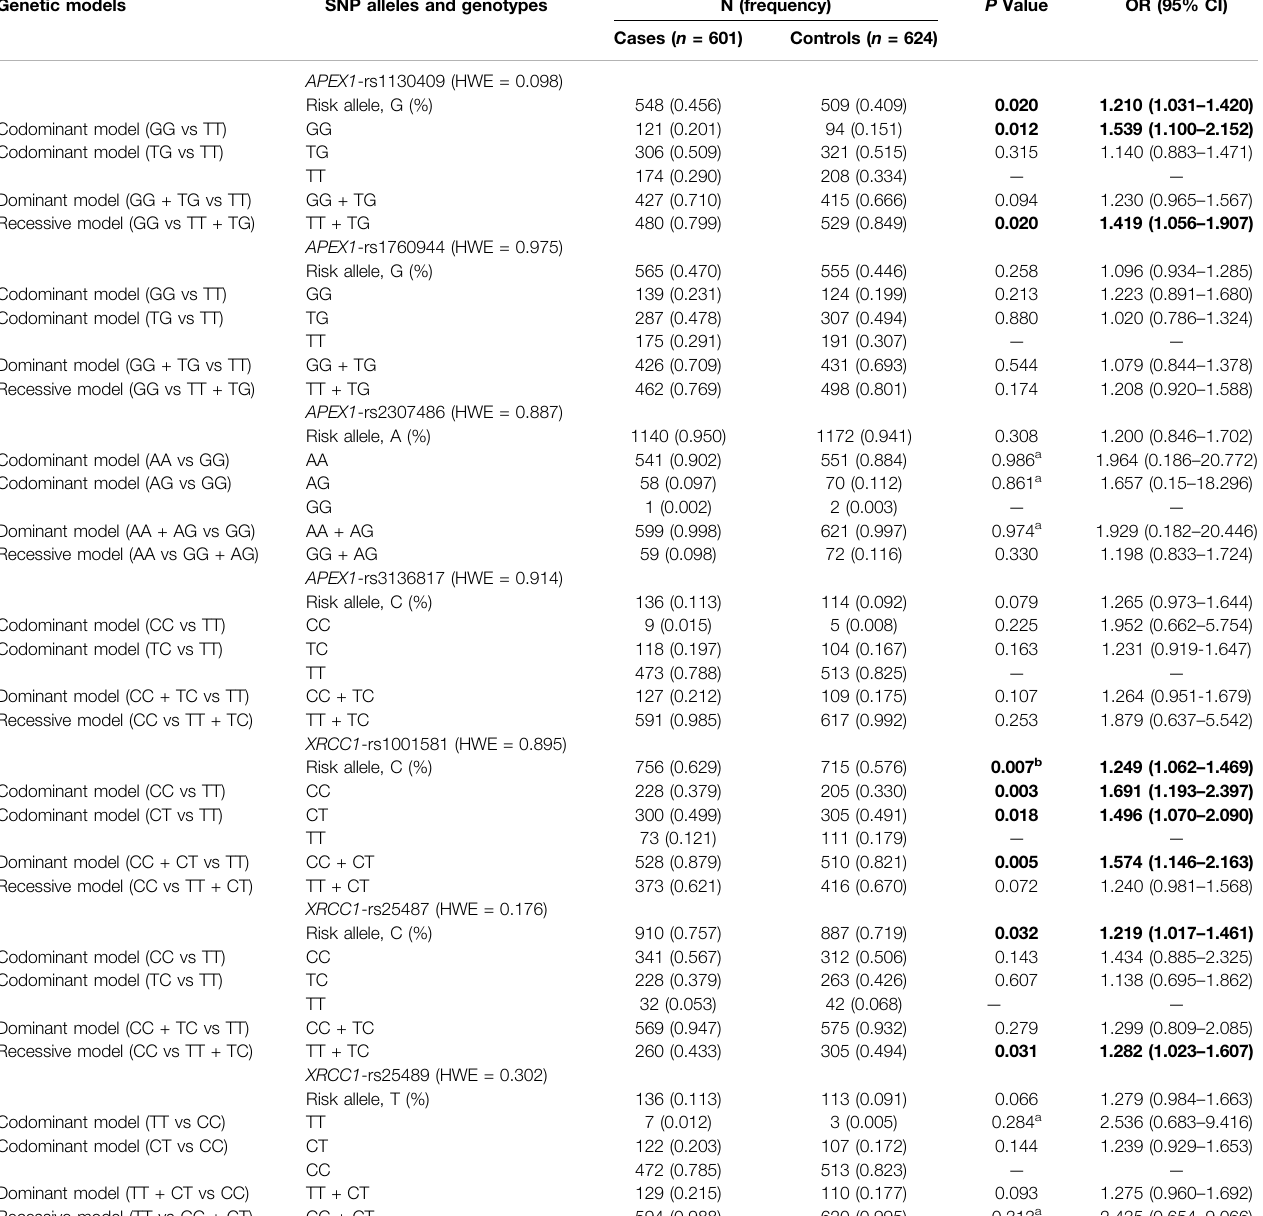
TABLE 2 | Associations between APEX1 and XRCC1 gene polymorphisms and susceptibility to HIV-1 infection. Genetic models SNP alleles and